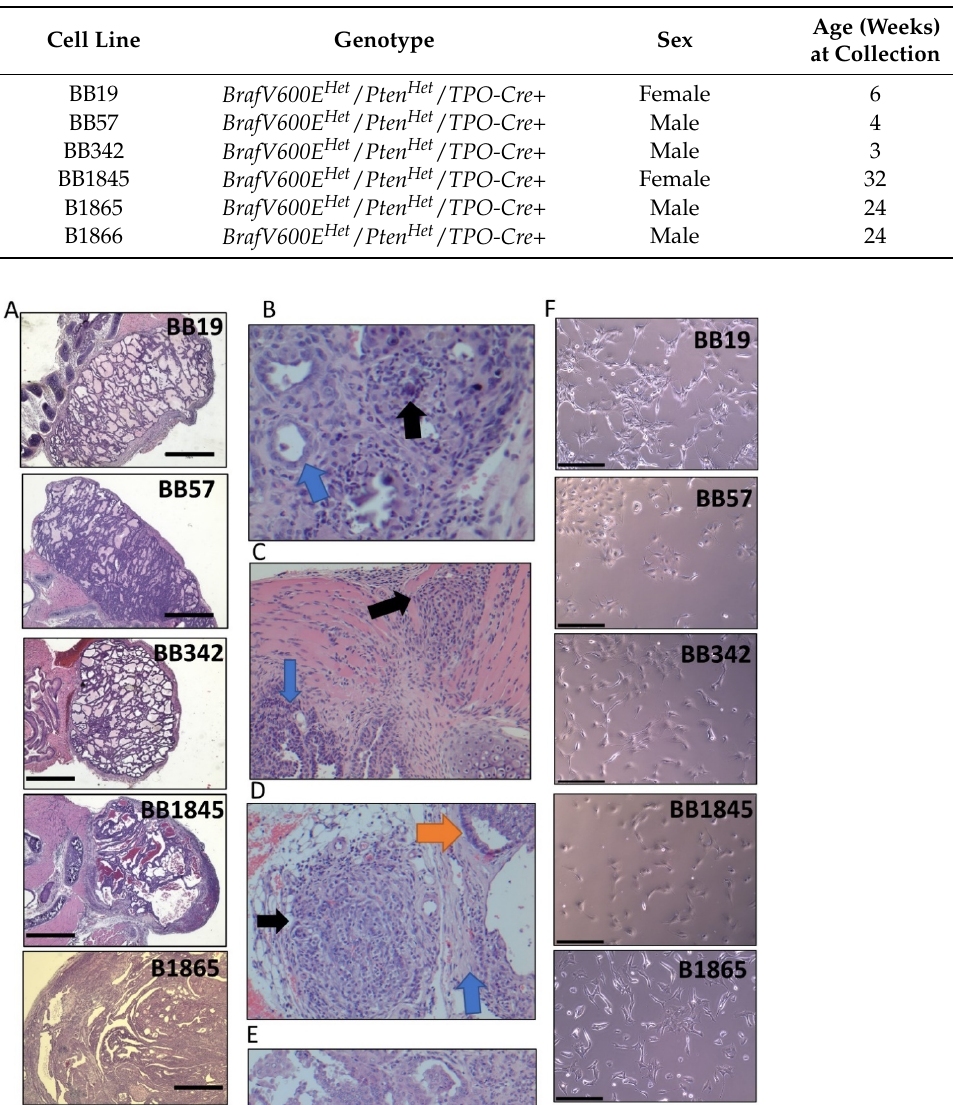
Table 1. Demographic information of the mice from which tumor cell lines were derived.